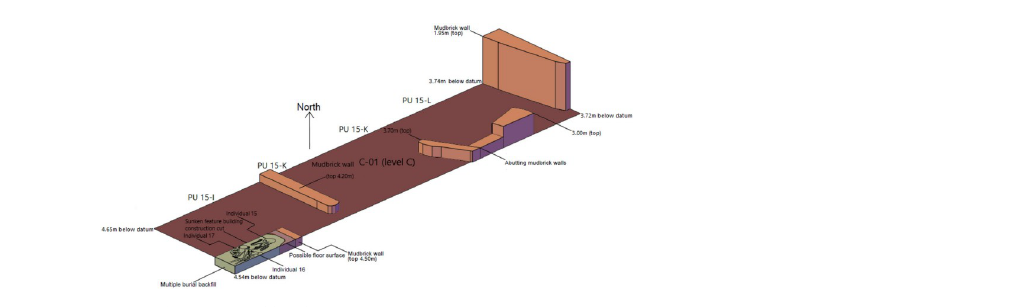
Fig 6. Planimetry of level C-01.